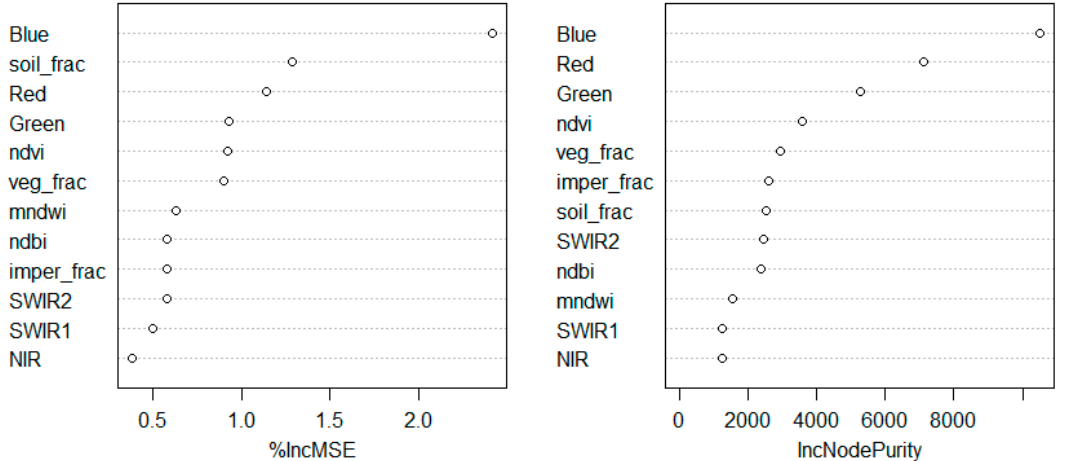
Figure 11 . RF importance ranking of independent variables for region B; imper_frac, veg_frac, and soil_frac stand for impervious surface, vegetation, and soil fractions, respectively. MNDWI is the modified normalized difference water index, NDBI is the normalized difference built-up index, and NDVI is the normalized difference vegetation index. 5. Discussion